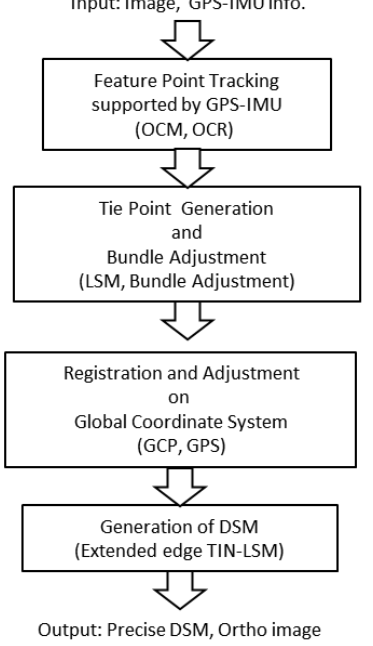
Figure 1. Processing Flow of Proposed